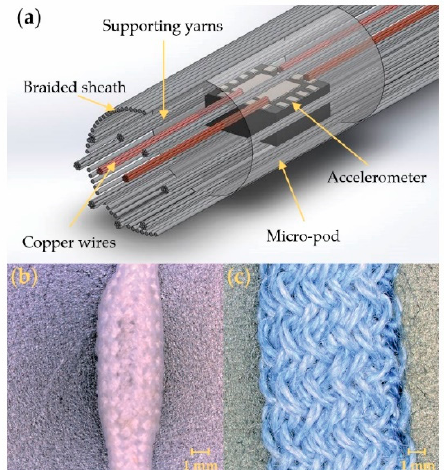
Figure 1. The vibration-sensing E-yarns. ( a ) Schematic of the final vibration-sensing E-yarn. ( b ) The final vibration-sensing E-yarn created using a braided outer sheath. ( c ) Vibration-sensing E-yarn constructed with a knit-braided outer sheath.